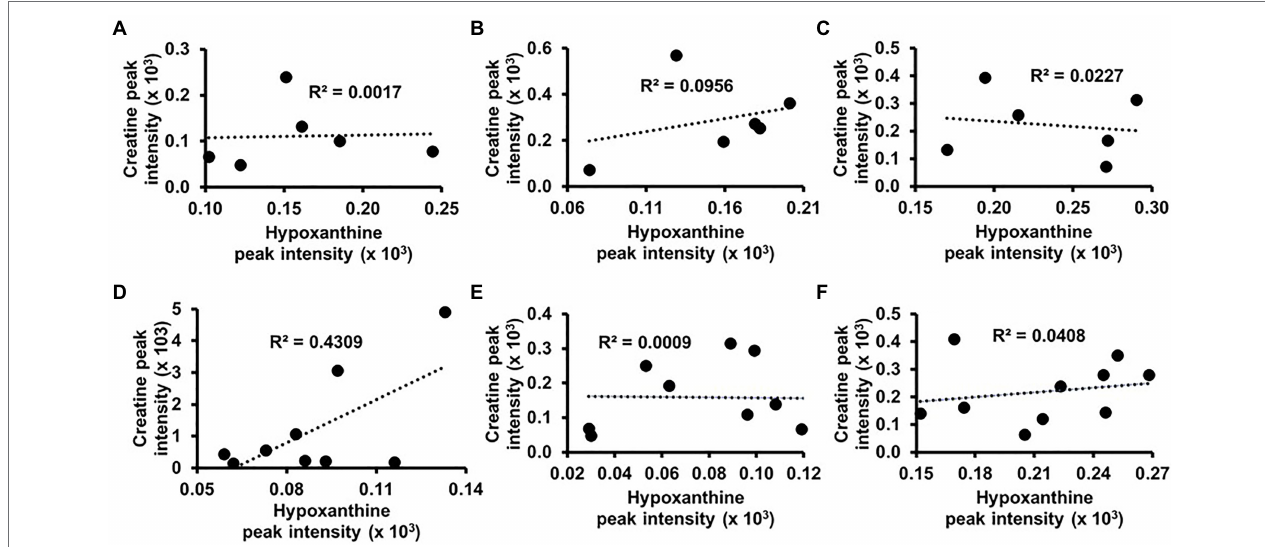
FIGURE 6 | Correlation analyses between urinary levels of creatine and hypoxanthine for NoAMS subjects at (A) SL, (B) 4,300 m on day 1 (HA1), (C) 4,300 m on day 18 (HA2), and AMS-susceptible individuals at (D) SL, (E) HA1, and (F)